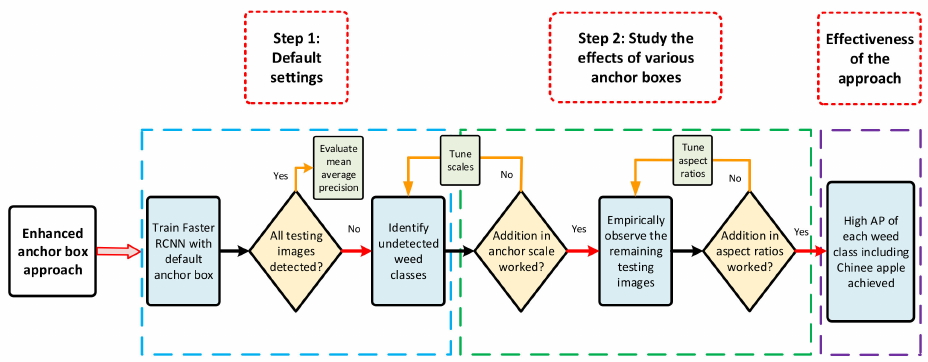
Figure 2. An explanation of the enhanced anchor box